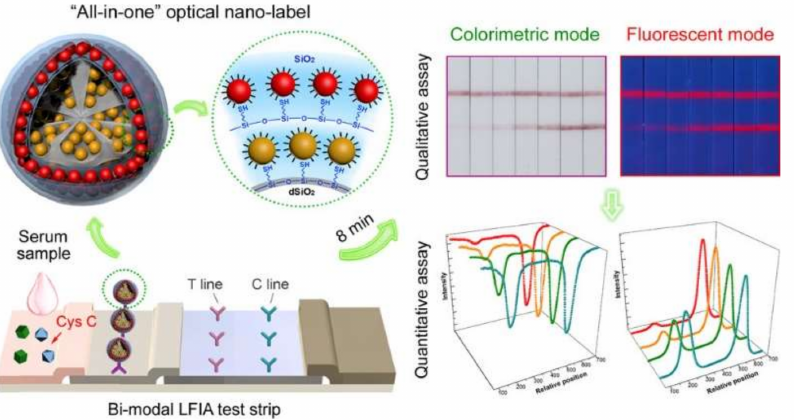
Figure 4. Dual-model LFA with both QDs (florescent) and AuNPs (colorimetric) integrated into DMSNs for early diagnosis of kidney injury. Reprinted with permission from Reference